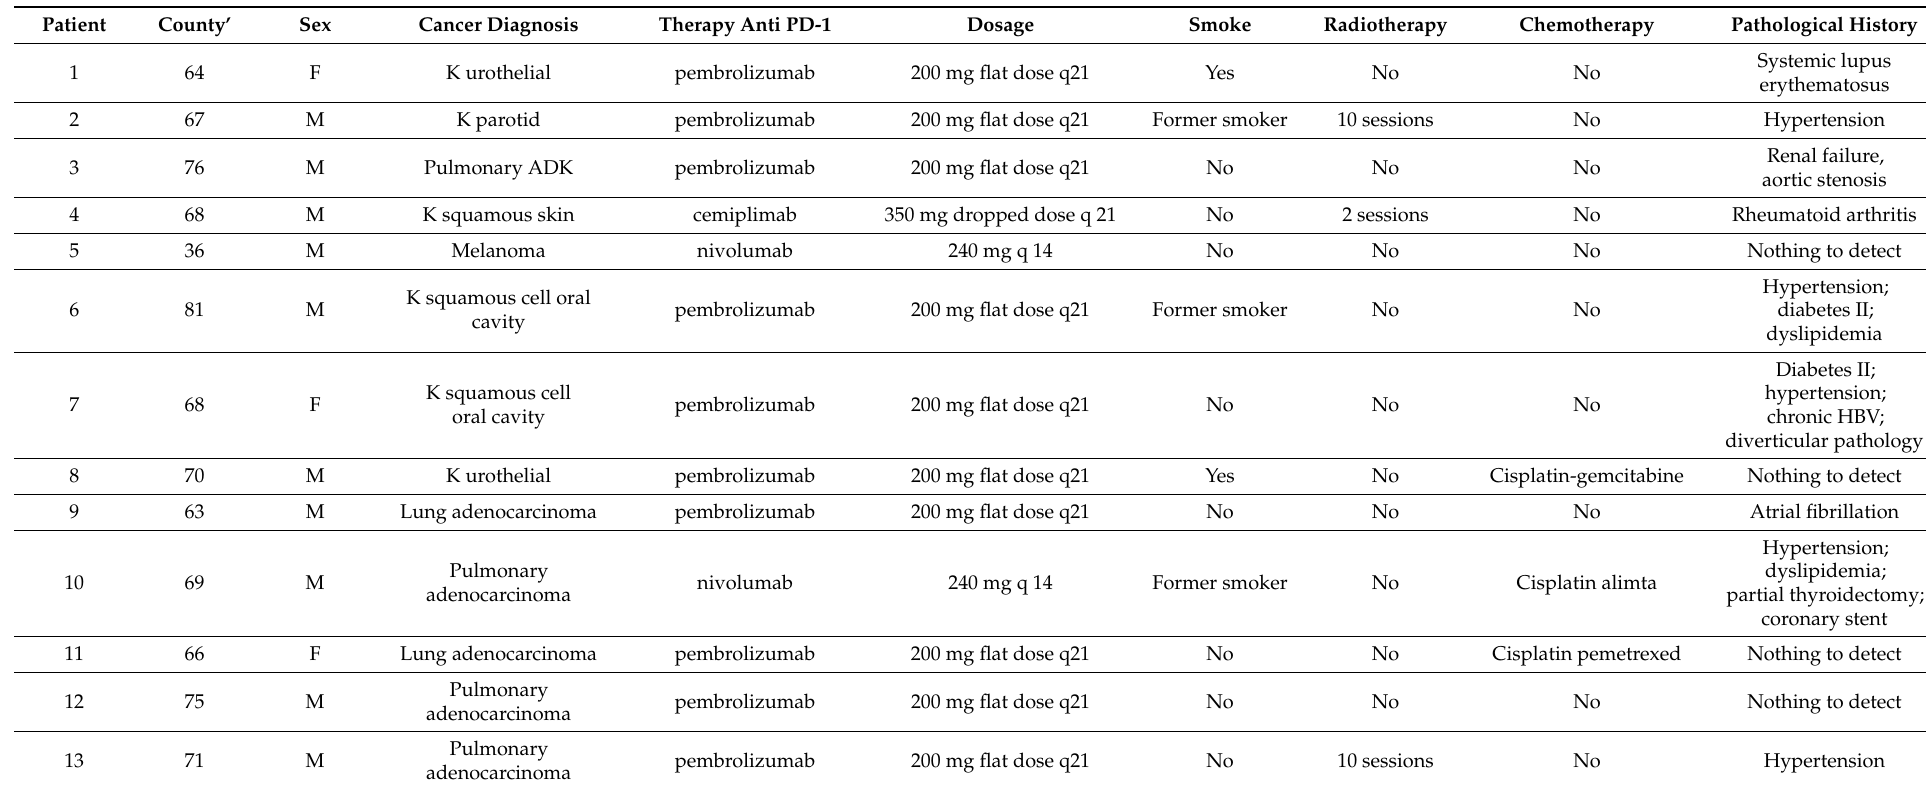
Table 1. Patient